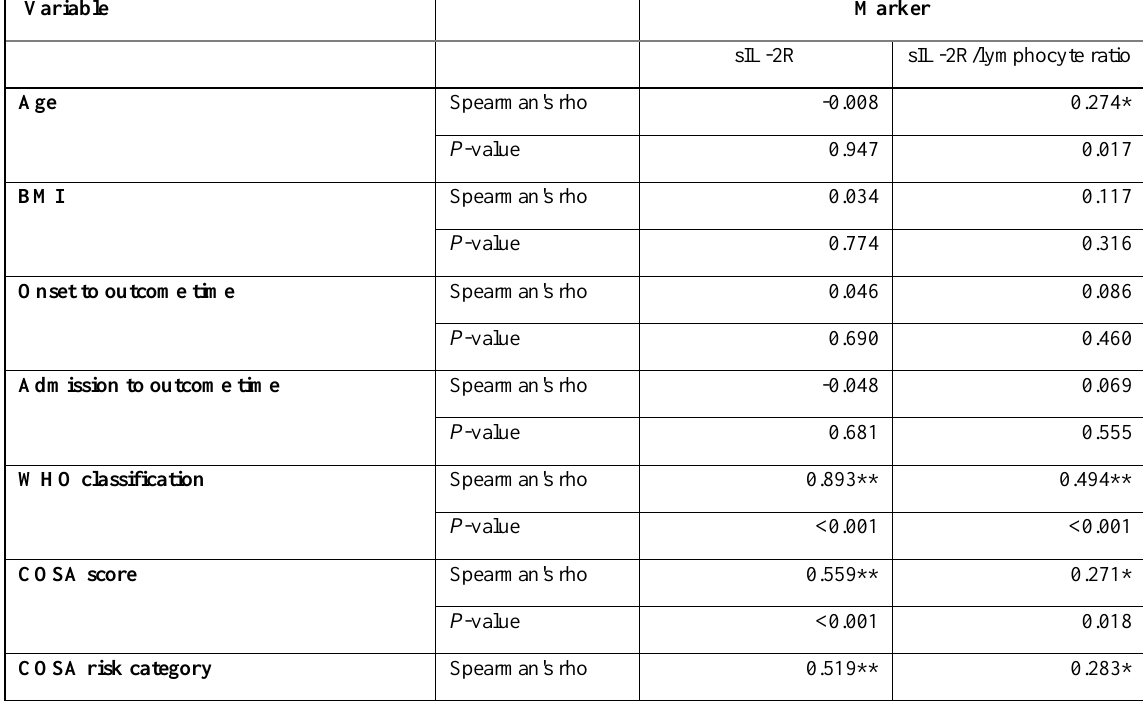
Table 4. Correlations of sIL-2R and sIL-2R/lymphocyte ratio with demographic, clinical and other laboratory